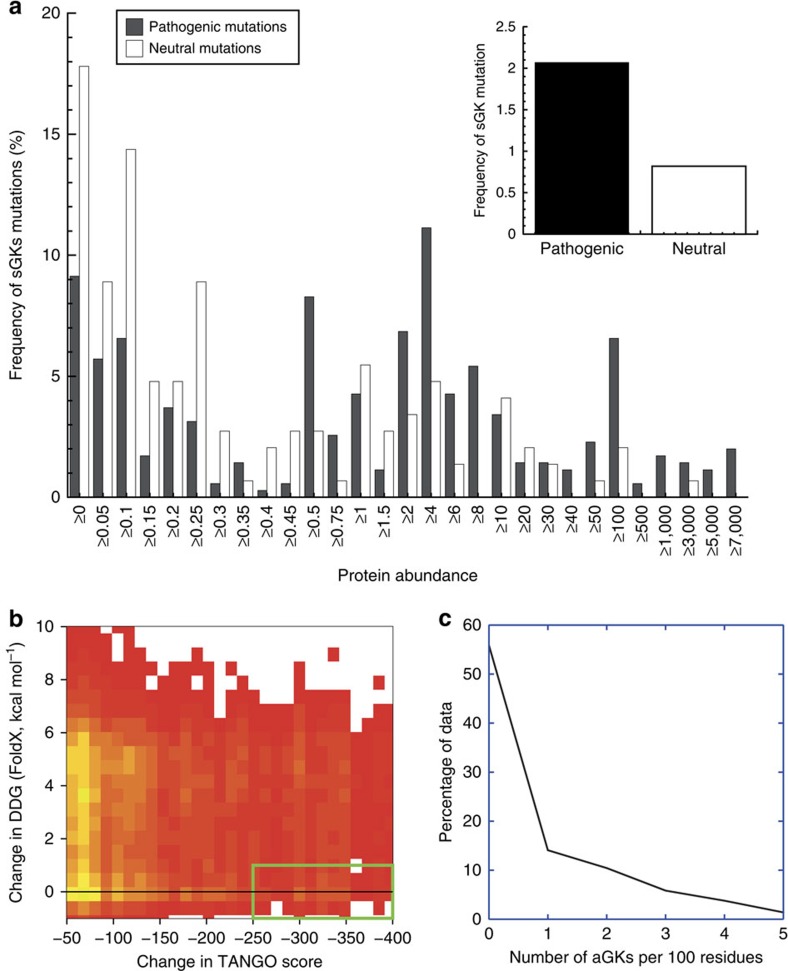
Potential for introducing artificial gatekeepers.(a) Comparison of the frequency of mutations that remove suppressing gakekeepers (sGKs) in pathogenic mutations and polymorphisms. The overall frequency is shown in the inset, whereas the main plot shows how the frequency of these mutations varies according to the cellular abundance of the WT proteins, showing that removal of a sGK is more likely to be neutral in proteins that occur at a low cellular concentration. (b) A systematic mutational scan of all residues of 4,730 APRs in 634 structurally diverse proteins. Each residue was mutated to Pro, Arg, Lys, Asp or Glu and its effect on intrinsic aggregation propensity and protein stability (ΔΔG) estimated using TANGO and FoldX, respectively. Heat map analysis (red to yellow gradient indicating increasing density) of the change in intrinsic aggregation propensity versus protein stability (ΔΔG) shows that the main density of mutations occurs at a high cost to thermodynamic stability and with moderate reductions of intrinsic aggregation and that only a minority of mutants significantly reduce aggregation without affecting thermodynamic stability (green box). (c) Density plot of the number of artificial gatekeepers within the green box of b that reduce significantly the aggregation propensity of an APR without affecting thermodynamic stability of the native structure (ΔTANGO<−250 and ΔΔG-value <1 kcal mol−1).